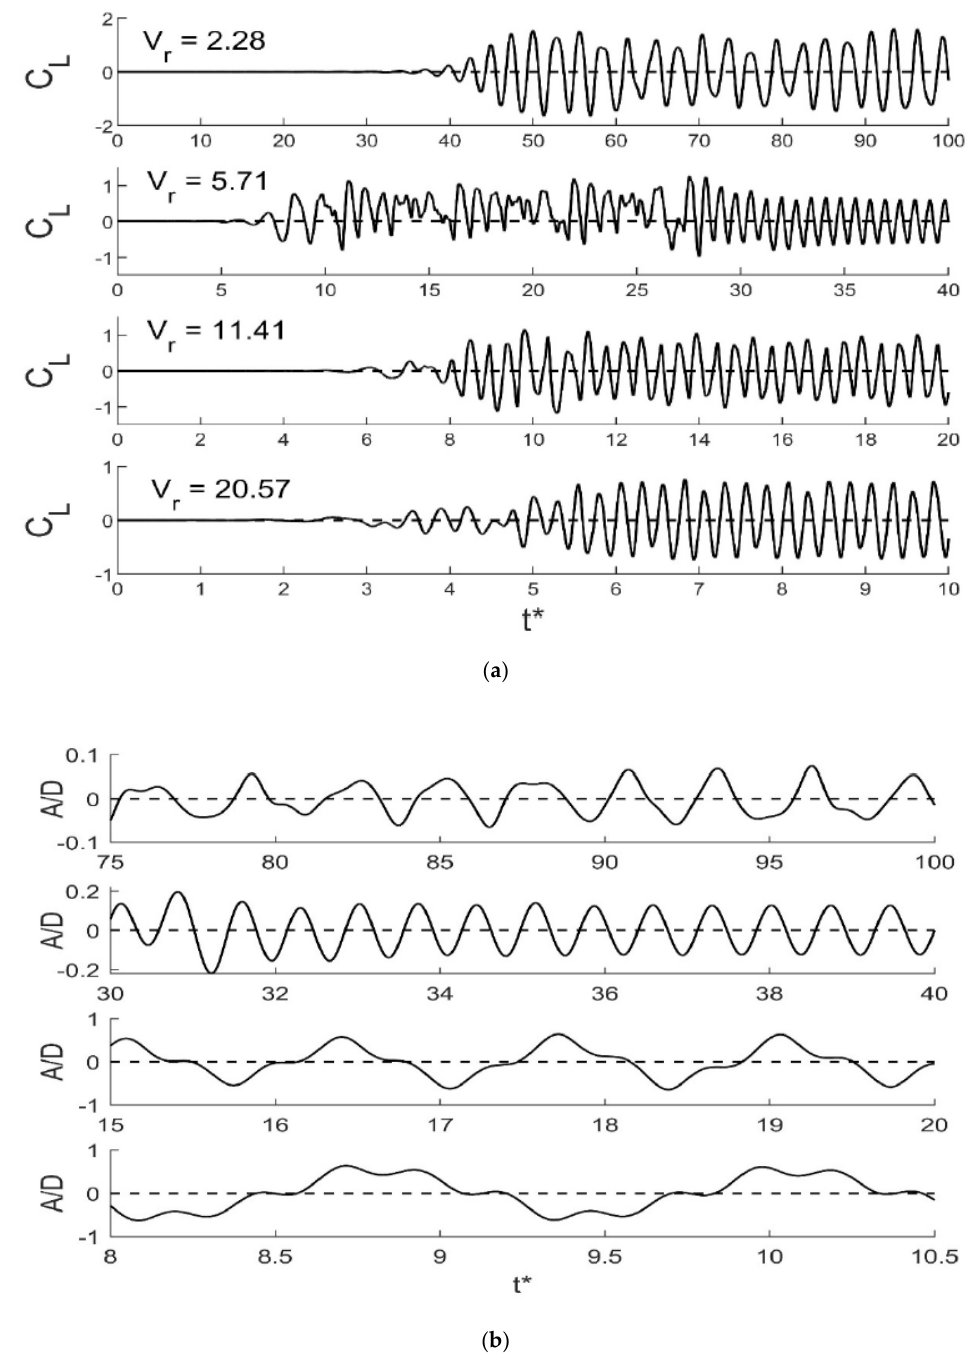
Figure 4. Time histories of the (a) lift coefficient and (b) normalized amplitudes of the corner-oriented hexagonal at 𝑉𝑟 = 2.28, 𝑉𝑟 = 5.71, 𝑉𝑟 = 11.41, and 𝑉𝑟 = 20.57. The lift time histories of the face-oriented hexagonal cylinders are shown in Figure 5a. At V r = 2 the mean value of the lift force is non-zero, and is on the positive side of the curve for the timespan considered. However, at V r = 5 the non-zero lift changes from a positive mean value (32 < t * < 34) to a